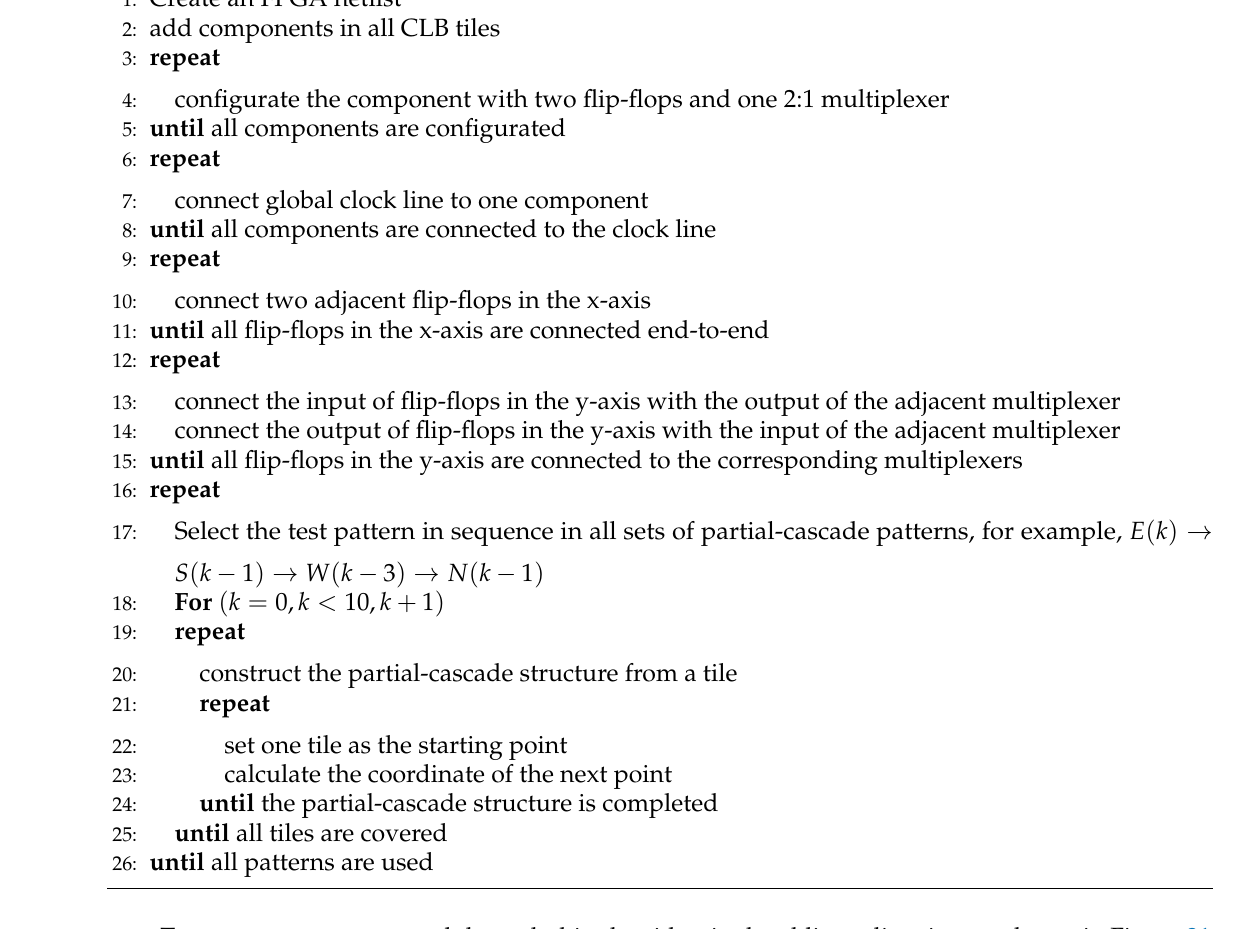
Algorithm 2 Automatic routing algorithm in the oblique direction, which can also be used for the middle PIPs